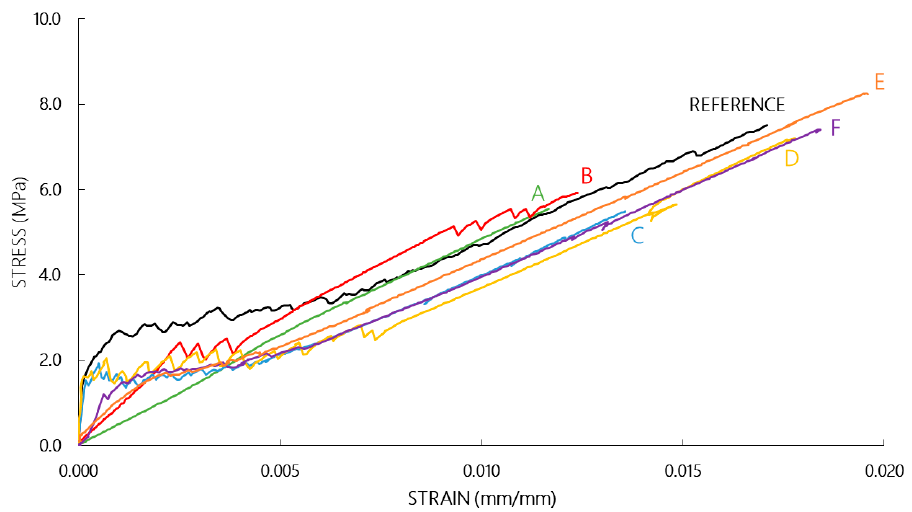
Figure 11. Residual behavior of TRC CYCL. 1.0 MPa.